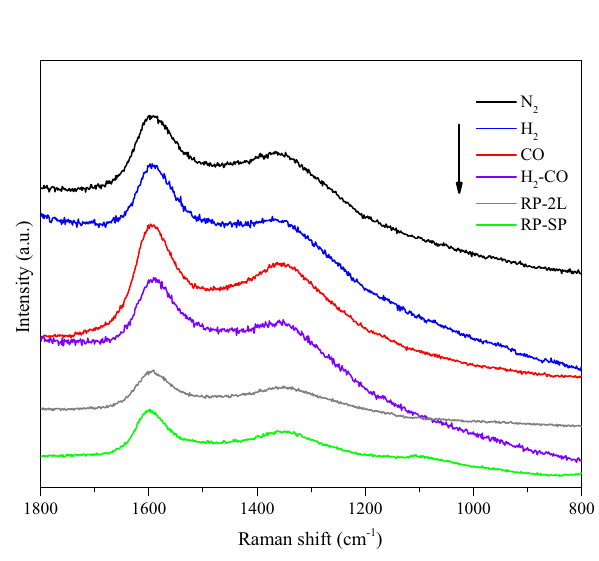
Fig. 8 Changes in Raman spectra of the chars produced under different atmosphere